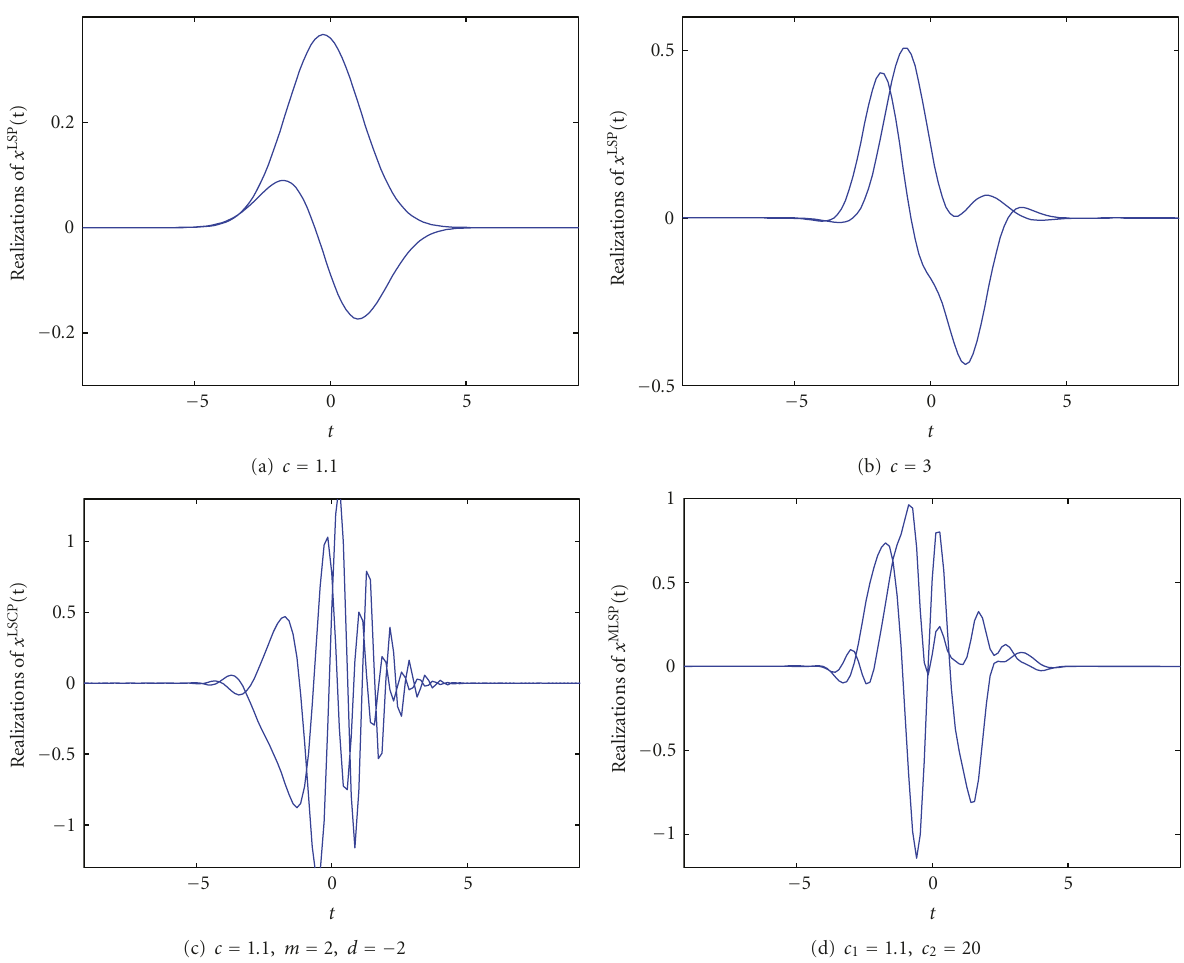
Figure 2: Process realizations corresponding to the covariance function r x ( t , s ) in Figure 1 for N = 256 and F s = 7: (a) LSP: c = 1 . 1, (b) LSP: c = 3, (c) LSCP: c = 1 . 1, m = 2, d = − 2 (real-valued part only), and (d) MLSP: c 1 = 1 . 1, c 2 =